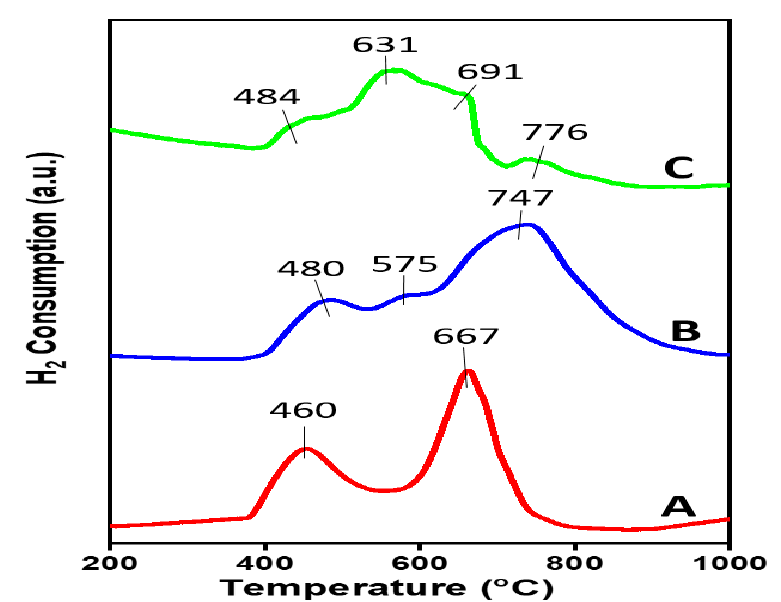
Figure 8. Temperature-programmed reduction (TPR) profiles of the prepared NiMo / CaTiO 3 catalysts calcined at different temperatures: (A) 600 ℃ , (B) 700 ℃ , and (C) 800 ℃ .